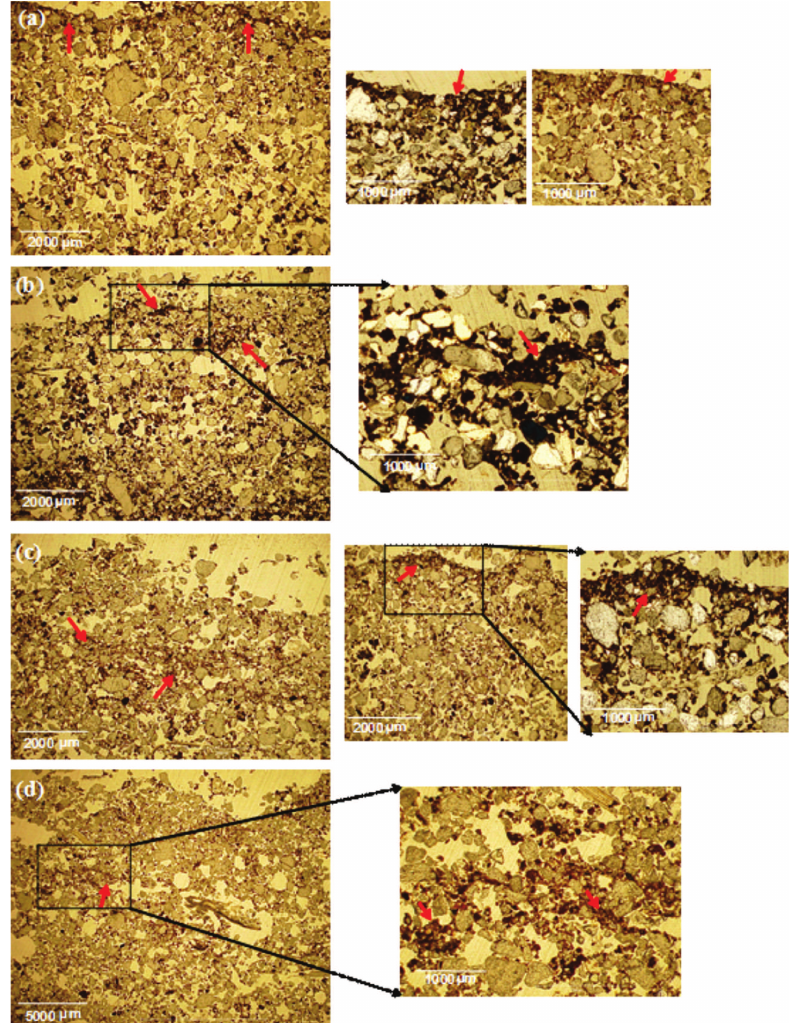
Figura 3. Detalhes da crosta formada no SP em razão das lâminas de chuva aplicada, sobre um Argissolo Vermelho-Amarelo. (a), (b), (c), (d) correspondem a 0, 27, 54 e 80 mm, respectivamente. Setas nas figuras indicam material disperso acumulado, podendo ser zonas de material grosso ou fino.